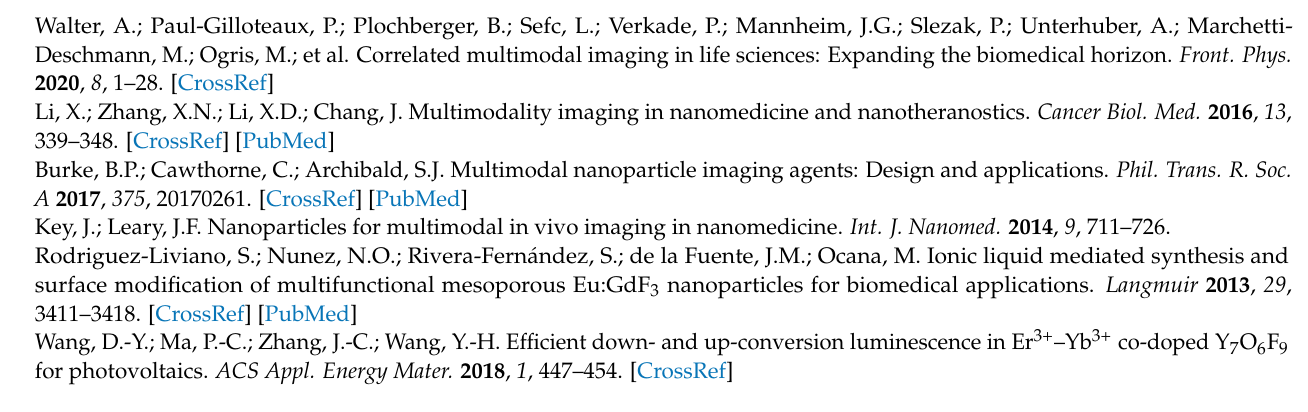
of Gd 3+ and Tb 3+ ions; 980 nm excitation, particle concentration 1 mg/mL, and power density 5 W/cm 2 . Figure S6: Cytotoxicity of P(DMA-AGME)-Ale-coated GdF 3 :Tb 3+ ,Yb 3+ ,Nd 3+ (black) and TbF 3 :Gd 3+ ,Yb 3+ ,Nd 3+ nanoparticles (red) incubated with Hela (dashed line) and HF cells (solid line) for 72 h. Figure S7: Laser scanning confocal micrographs of (a–c) HF and (d–f) HeLa cells (a,d) before (negative control) and after treatment with (b,e) TbF 3 :Gd 3+ ,Yb 3+ ,Nd 3+ @P(DMA-AGME)-Ale and (c,f) GdF 3 :Tb 3+ ,Yb 3+ ,Nd 3+ @P(DMA-AGME)-Ale nanoparticles. Figure S8: (a–f) Confocal micrographs of biodistribution of TbF 3 :Gd 3+ ,Yb 3+ ,Nd 3+ @P(DMA-AGME)-Ale nanoparticles in INS cells at 808 nm excitation with a laser power of 30–50 mW. (d–f) Detailed micrographs of (a–c). (a,d) CellMask™ deep red-stained cell membrane, (b,e) nanoparticles (green), and (c,f) overlay of (a,b) and (d,e), respec- tively. Figure S9: Emission spectra of pure GdF 3 :Tb 3+ ,Yb 3+ ,Nd 3+ @P(DMA-AGME)-Ale nanoparticles (black) and nanoparticles localized in the HepG2 cells (red). Figure S10: (a,c) Relative T 1 and (b,d) T 2 * signal evolution in the liver, kidney (medulla and cortex), and spleen after administration of P(DMA-AGME)-Ale-coated (a,b) TbF 3 :Gd 3+ ,Yb 3+ ,Nd 3+ and (c,d) GdF 3 :Tb 3+ ,Yb 3+ ,Nd 3+ nanopar- ticles in mice. Figure S11: Dependence of CT value of Gd(Tb)F 3 :Tb 3+ (Gd 3+ ),Yb 3+ ,Nd 3+ @P(DMA- AGME)-Ale nanoparticles and Iohexol on the concentration. HU - Hounsfield units. Figure S12: Relative signal evolution of the CT contrast (HU) in the liver and kidneys calculated from pre- injection to 48 h post-injection of GdF 3 :Tb 3+ ,Yb 3+ ,Nd 3+ @P(DMA-AGME)-Ale nanoparticles. Error bars represent the standard deviation from two independent images. Figure S13: Photolumines- cence spectra of Cy7-modified Gd(Tb)F 3 :Tb 3+ (Gd 3+ ),Yb 3+ ,Nd 3+ @P(DMA-AGME)-Ale nanoparti- cles. Figure S14: Fluorescence imaging of the excised mouse organs 168 h after administration of GdF 3 :Tb 3+ ,Yb 3+ ,Nd 3+ @P(DMA-AGME)-Ale-Cy7 nanoparticles. Table S1: Characterization of GdF 3